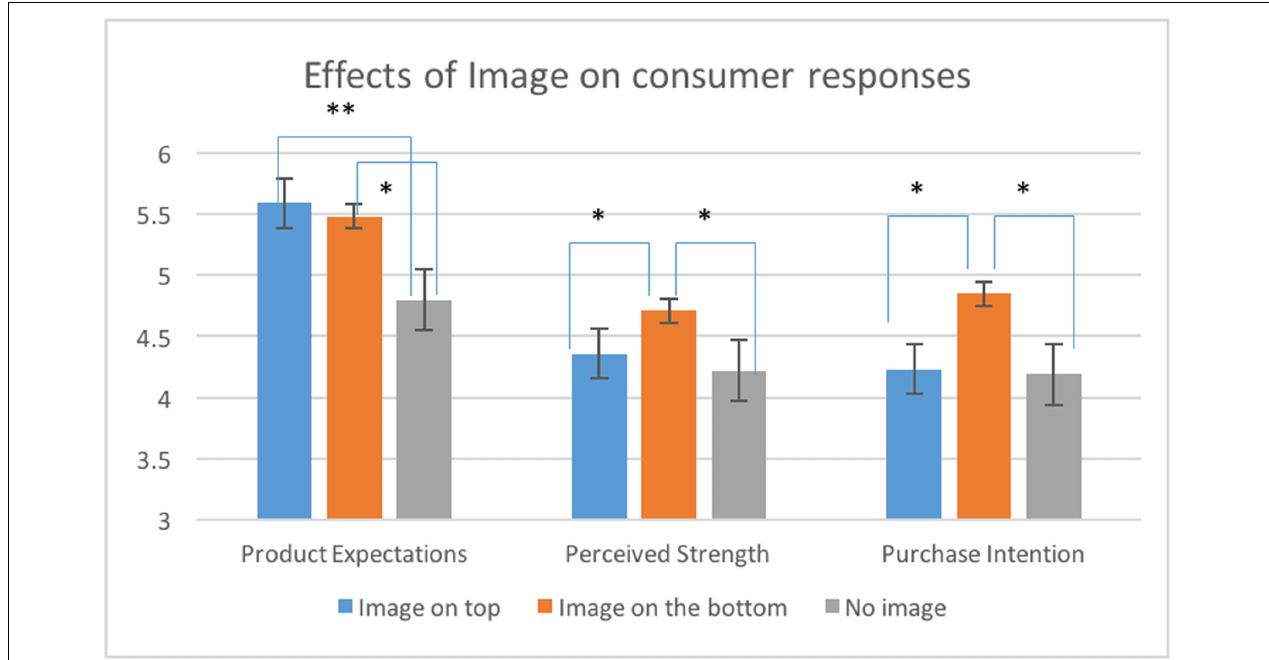
FIGURE 7 | Mean product expectations, perceived strength and purchase intention ( ± SE) for packages with the image on top of the package, on the bottom of the package and packages without an image. ∗∗ The effect is significant at 0.01 level; ∗ the effect is significant at 0.05 level.